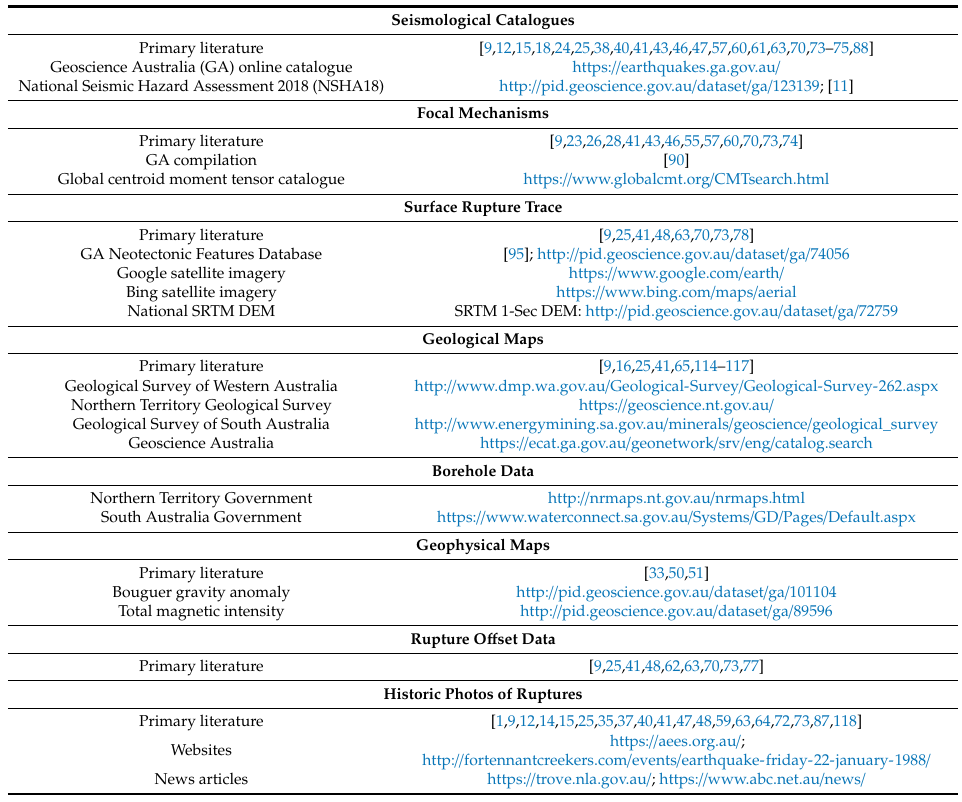
Table 2. Summary of data sources used in reviewing Australian historic surface